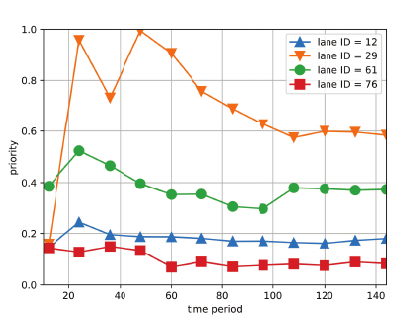
Figure 3. The priority of multiple road segments under different time